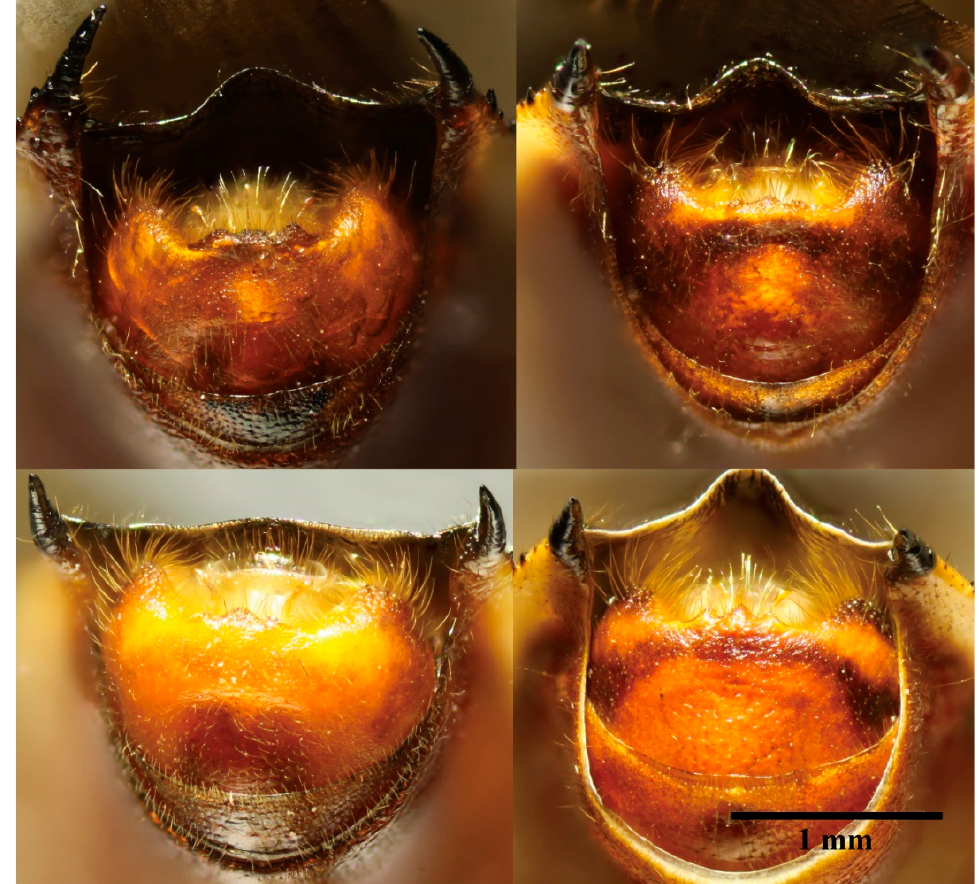
Figure 5. 45 degree angle views of the ventral surface for four samples of the new species, N. bispina sp. nov . showing the teeth variation on the posterior margin of male genital capsule.